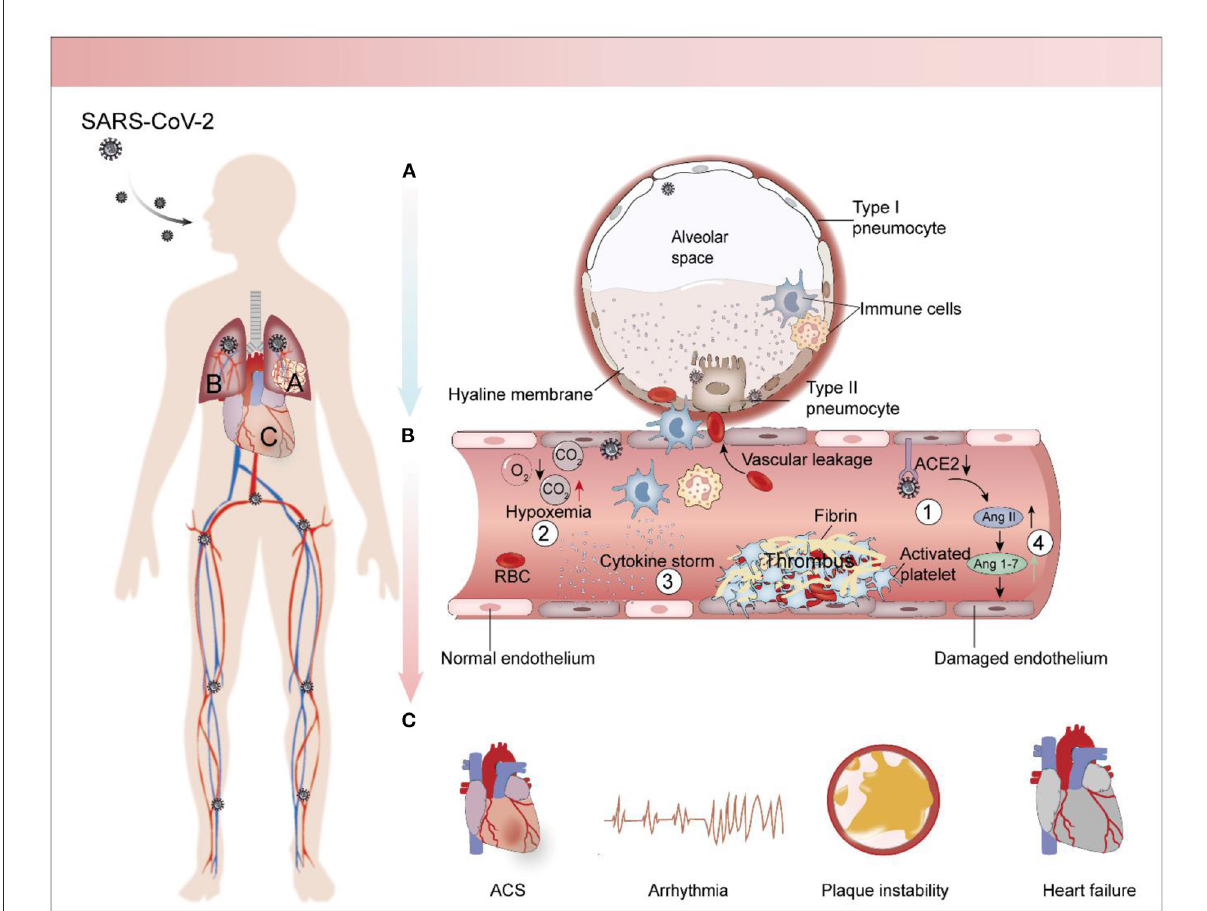
FIGURE1 Pathological mechanism of cardiopulmonary complications caused by SARS-CoV-2. (A) Pathophysiology of SARS-CoV-2-infected lungs. The virus infects alveolar type II epithelial cells and pulmonary capillary endothelial cells through the respiratory tract and stimulates immune cells to release inflammatory factors, causing cytokine storm. As viral replication enters into the bloodstream, it stimulates endothelial cell shrinkage and narrows the pulmonary capillary lumen. This causes a local lack of oxygen to the lungs. Endothelial cells damage worsens as the